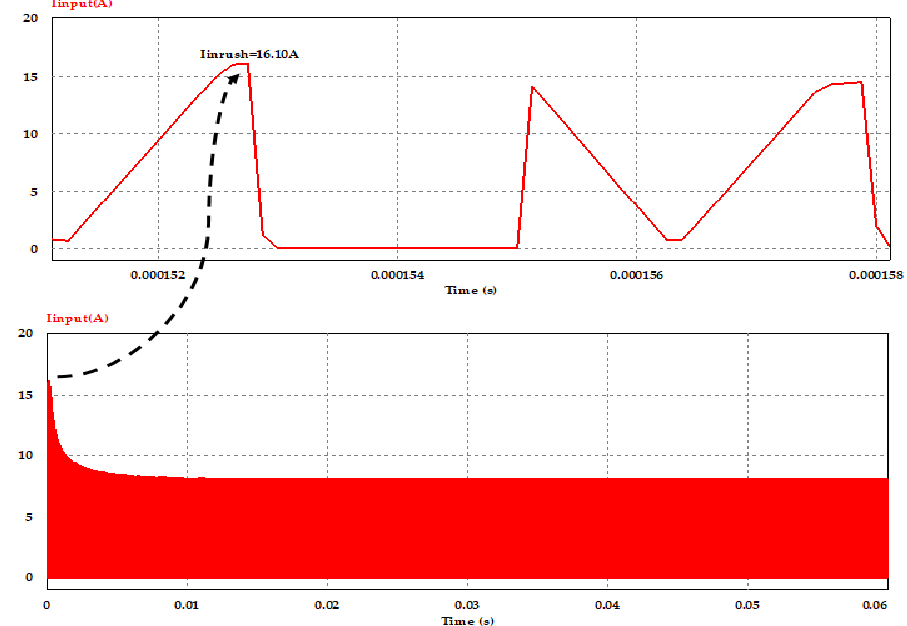
Figure 12. Converter input current without inrush current mitigation circuit at full load and V in = 400 V.